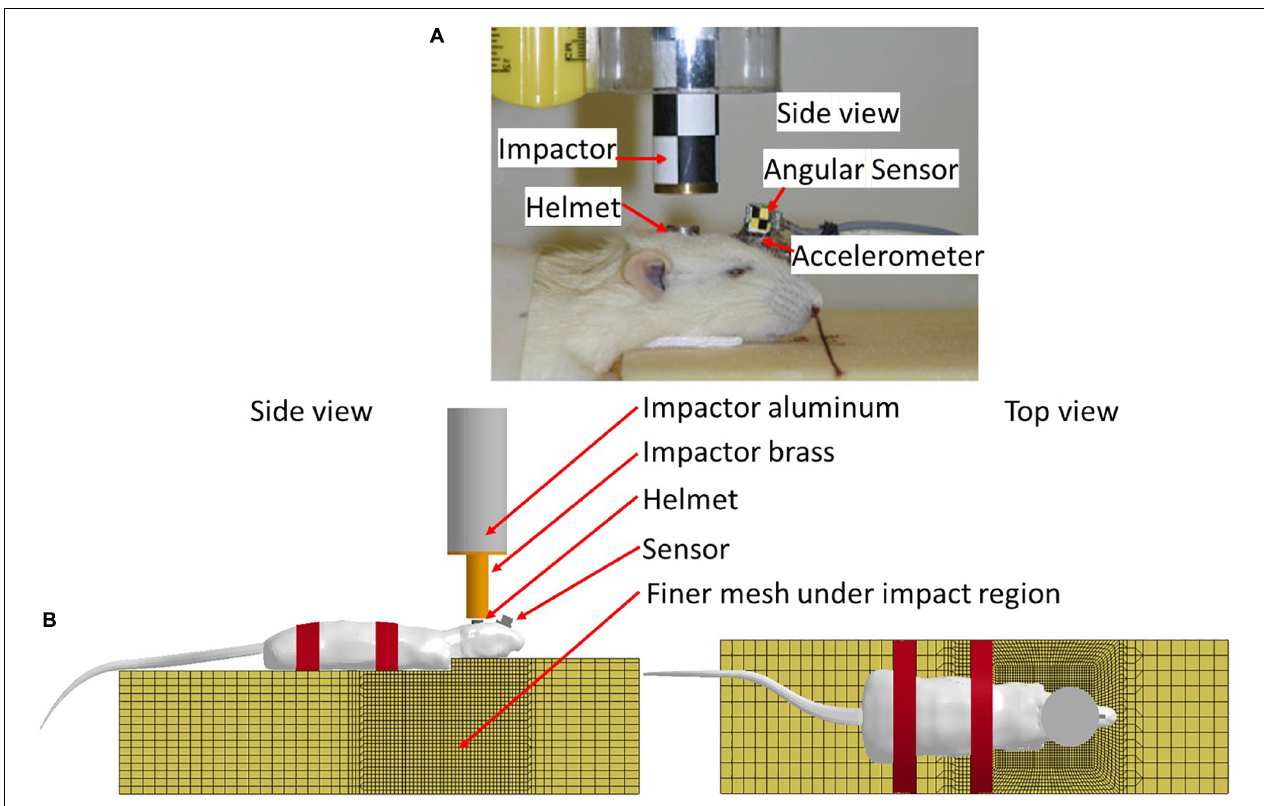
FIGURE 3 | (A) Rat head impact experimental setup and the sensors used; (B) FE model set up simulating rat head impact acceleration experiment (side and top